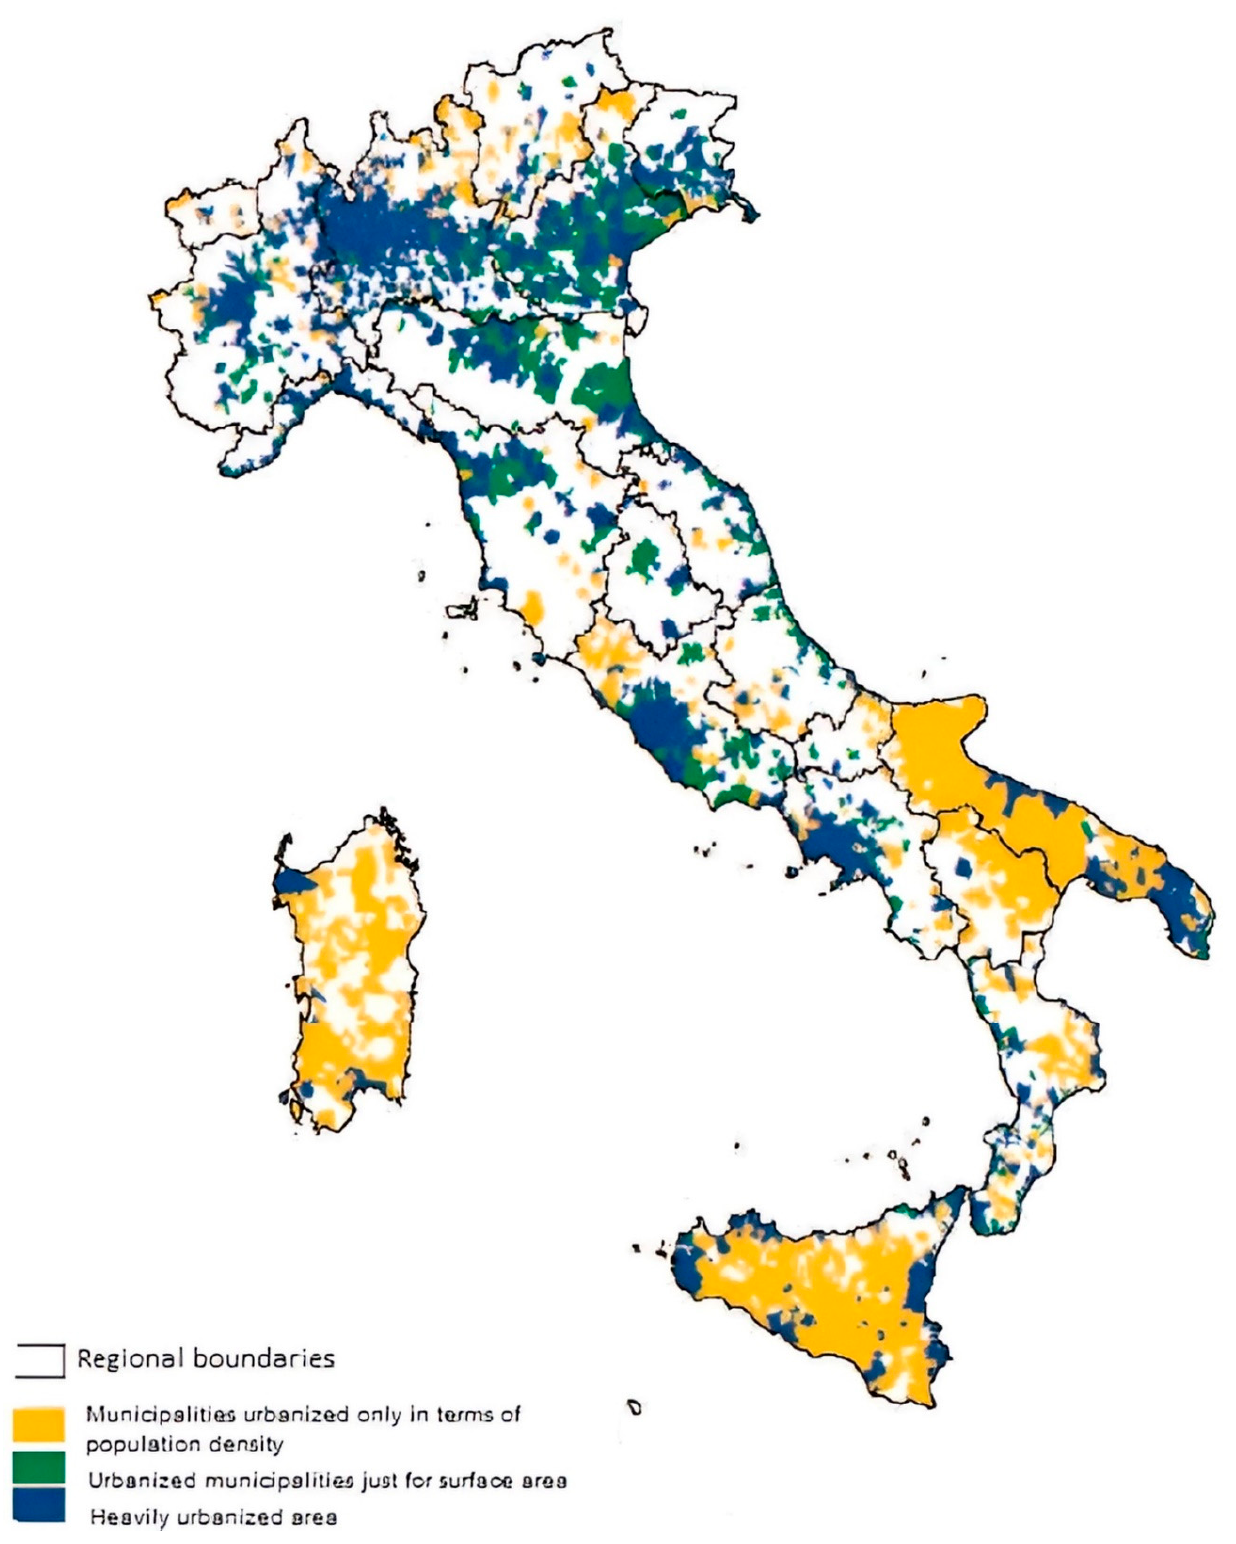
Figure 4. The representation of Italy after applying the Barbieri and Cruciani method (2). Territorial classification for each municipality in Italy. Source: Barbieri and Cruciani, 2007.